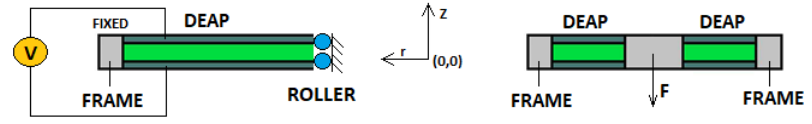
Figure 10. Mechanical Boundary conditions for experiments and ANSYS Environment.